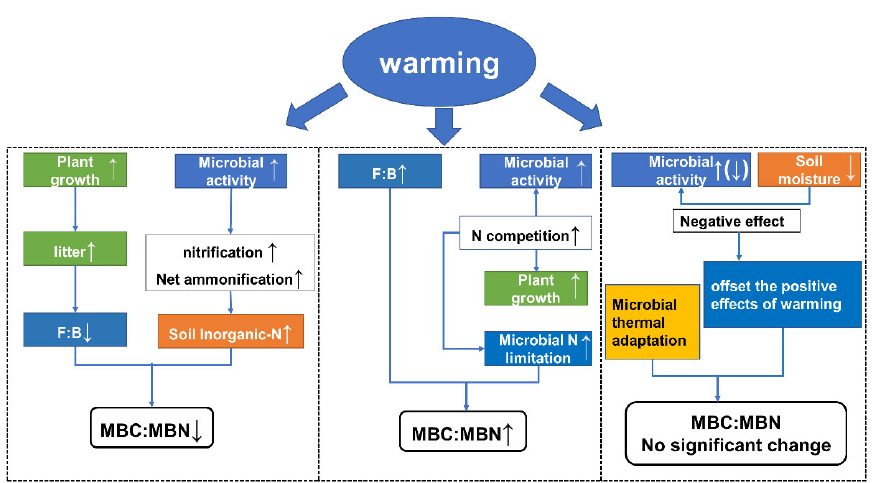
Figure 2. A conceptual framework for the responses of soil microbial biomass C:N to warming in alpine ecosystems. ↑ , increase; ↓ , decrease; F:B, fungi ‐ to ‐ bacteria ratio.